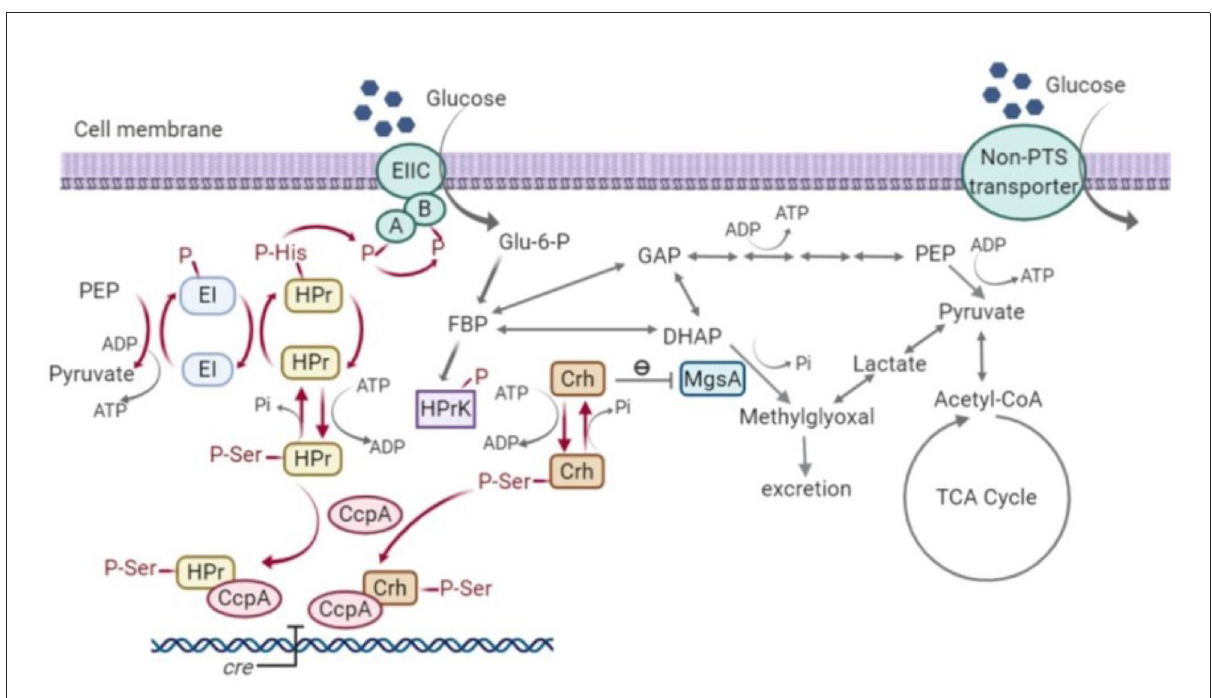
FIGURE10 Signal transduction pathway of carbon catabolite repression (CCR) and methylglyoxal pathway in Bacillus subtilis (Görke and Stülke, 2008; Fujita, 2009; Landmann et al., 2011). HPr, phosphocarrier protein; Crh, catabolite repression HPr; CcpA, carbon catabolite protein A; HPrK, HPr kinase; MgsA, methylglyoxal synthase; GAP, glyceraldehyde-3-phosphate; DHAP, dihydroxyacetone phosphate; EI, Enzyme I; EII, Enzyme II; PEP, phosphoenolpyruvate; Glu-6-P, glucose-6-phosphate; FBP, fructose-1,6-bisphosphate; Acetyl-CoA, acetyl-coenzyme A; TCA, tricarboxylic acid cycle; cre , catabolite-response